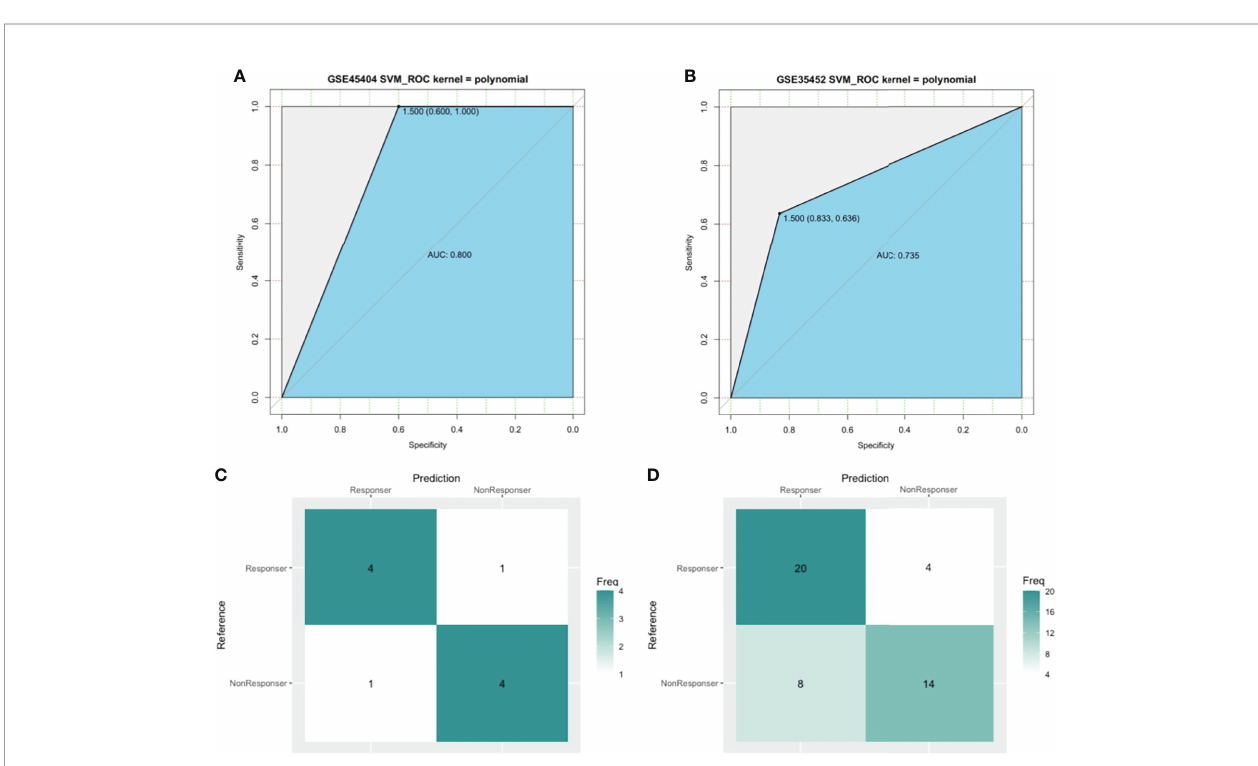
FIGURE 7 | The model measured by receiver-operating characteristic (ROC) curves in GSE45404 dataset (internal validation) and GSE35452 dataset (external validation). (A, B) ROC curve. The horizontal axis indicated the speci fi city and the vertical axis indicated the sensitivity. (C, D) confusion matrix. The horizontal axis indicated the predictive case numbers and the vertical axis indicated the present case numbers.